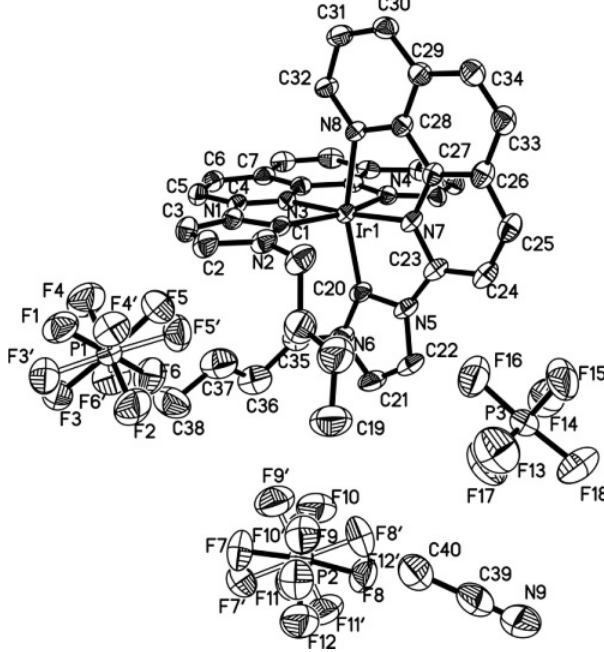
dryness, and the residue was washed with diethyl ether. Yield: 58 mg, 46 %. White air stable single crystals were grown by slow